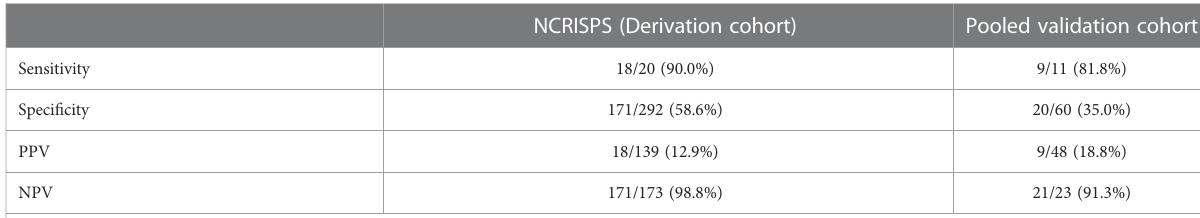
NCRISPS,Newcardiovascularriskfactorprevalencestudy;MAFLD,metabolicdysfunction-associatedfattyliverdisease;LS,liverstiffness;PPV,positivepredictivevalue;NPV,negative predictive value.